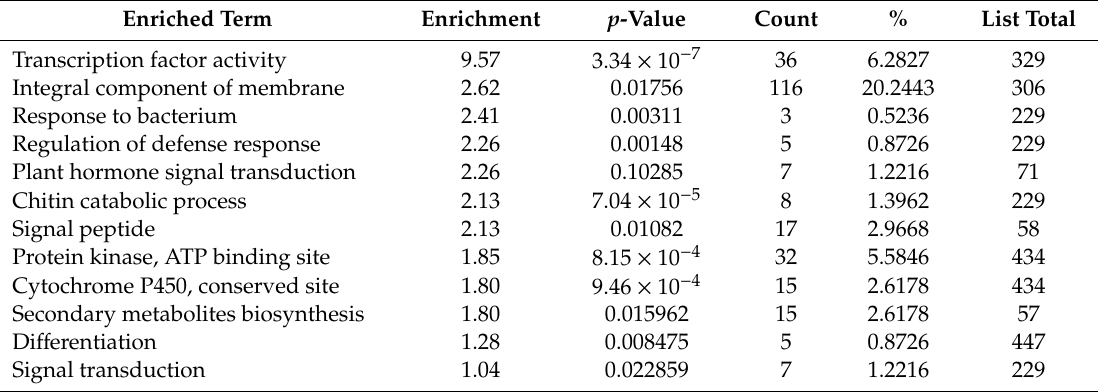
Figure 3. Expression analysis of di ff erentially expressed genes (DEGs) in response to X. oryzae pv. oryzae race K2 interaction. ( A ) Heat-map showing the expression patterns of all di ff erentially expressed genes in four libraries. From left to right, the four columns respectively show the expression of genes in the non-inoculated Dongjin (DJ; susceptible type), inoculated DJ, non-inoculated Jinbaek (JB; resistant type), and inoculated JB. Green, black, and red respectively indicates low, no change, and high expression levels of genes. ( B ) The number of DEGs in treated JB (JB_48 vs. JB_0), treated DJ (DJ_48 vs. DJ_0), and a combination of both. Dark bar represents up-regulated; gray bar represents down-regulated DEGs. ( C ) Venn diagram showing the number of genotype-specific (unique) genes and overlapping genes. Table 1. Representative term of most enriched annotation group ( p ≤ 0.05) determined by functional annotation clustering in